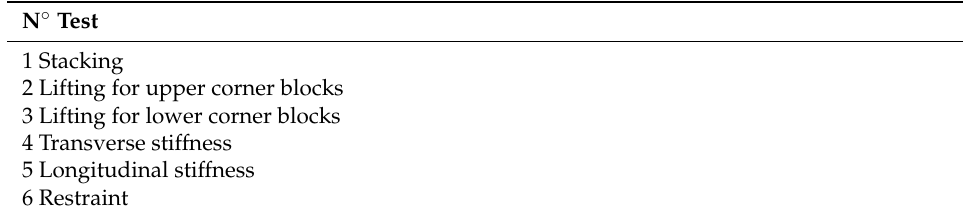
Table 1. ISO standard test on tank container.